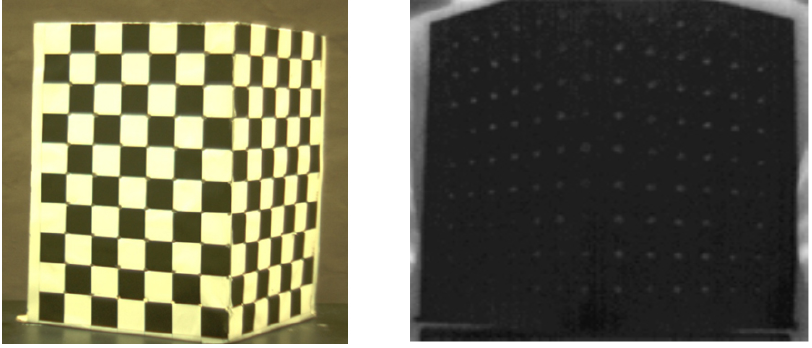
Figure 7. Images of the calibration rig taken by the visible camera ( left ) and the thermal-IR camera ( right ).